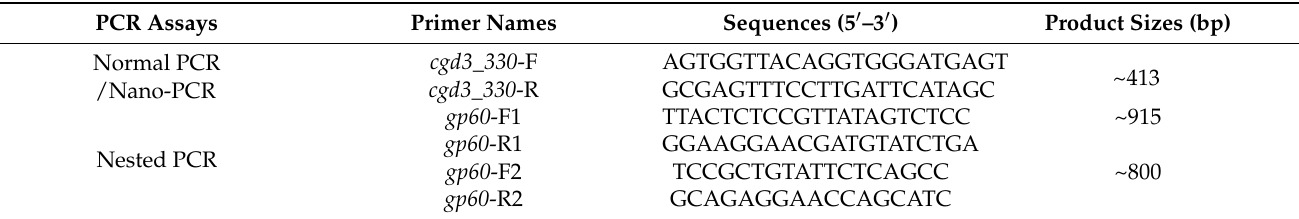
Table 1. Sequences of the primers used in this